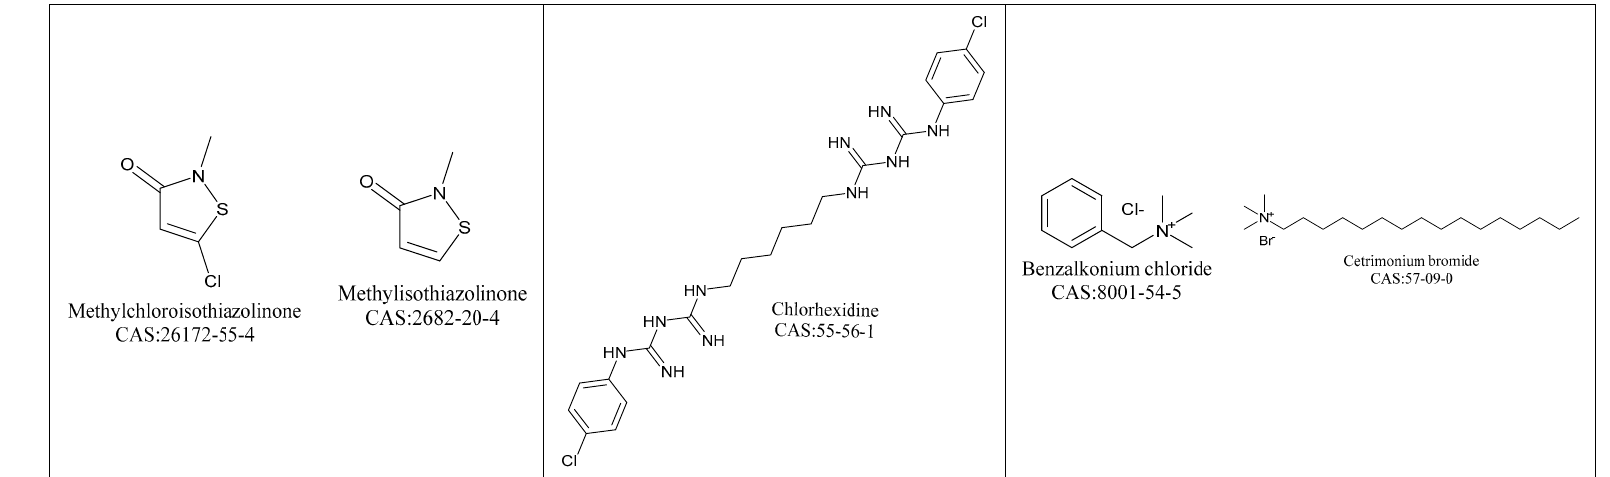
Figure 3. Chemical structures of some preservatives used in cosmetics.